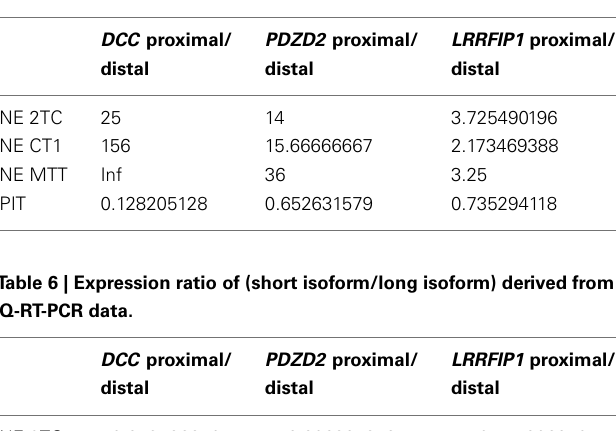
Table 5 | Expression ratio of (short isoform/long isoform) derived from DRS data.